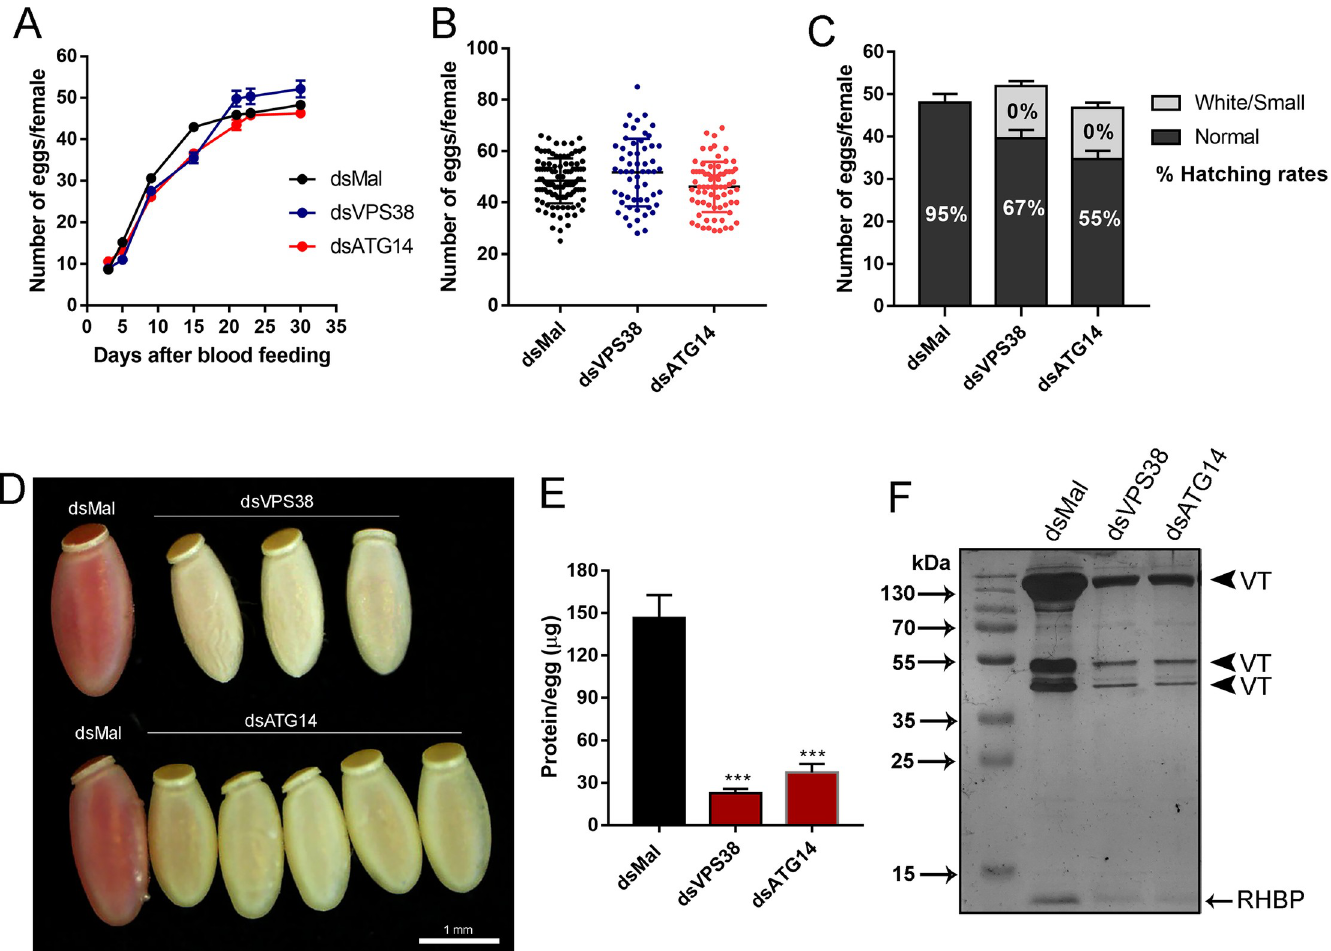
Fig 4. Silencing of VPS38/UVRAG and ATG14 does not alter oviposition but decreases embryo viability. A. Number of eggs laid per female over 4 weeks after the blood meal. Graph shows mean ± SEM (n = 52). B. Total of eggs laid by silenced and control females. Graph shows mean ± SEM (n = 52). C. Phenotypic distribution of the F1 eggs observed after knockdown of VPS38/UVRAG and ATG14. Percentage (%) of hatching per phenotype is also showed inside the bars. D. Representative image of the phenotypes observed in the F1 eggs laid by control and silenced females. E. Total amount of protein from control and VPS38/UVRAG and ATG14 silenced eggs, measured by the Lowry method. Graph shows mean ± SEM (n = 6). ��� p < 0.001, One Way ANOVA. F. 13% SDS-PAGE showing the protein profile of freshly laid eggs from control and silenced females. Arrowheads, VT, Vitellin subunits; RHPB– Rhodnius Heme Binding Protein (n =